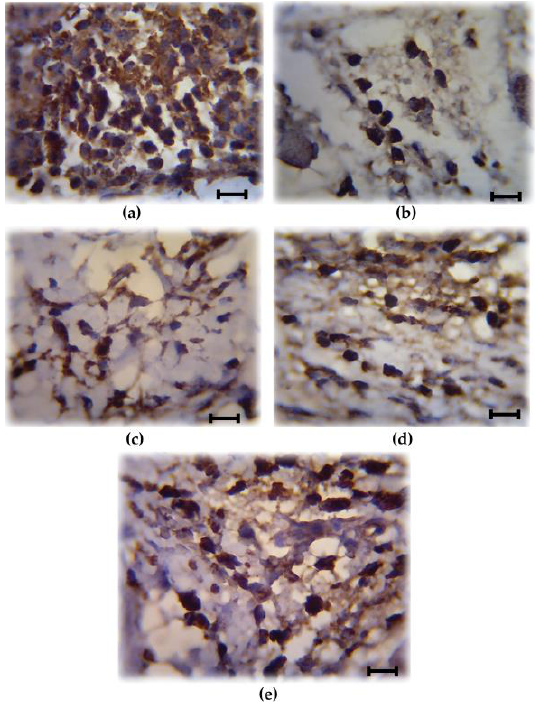
Figure 2. Representative photos showing the cyclooxygenase (COX)-2 expressing cells (stained dark-brown) of the paw edema. ( a ) Solvent-treated group; ( b ) Indomethacin-treated group; ( c – e ) HIFPL-treated group at 160, 80 and 40 mg/kg (per oral), respectively. The soft plantar region sections of the hind paw were cut and fixed, COX-2 expression was detected using immonohistochemisty. The number of COX-2 expressing cells were counted in a light microscope with a 1000 × magnification at five different fields. Scale bar: 10 µ m.